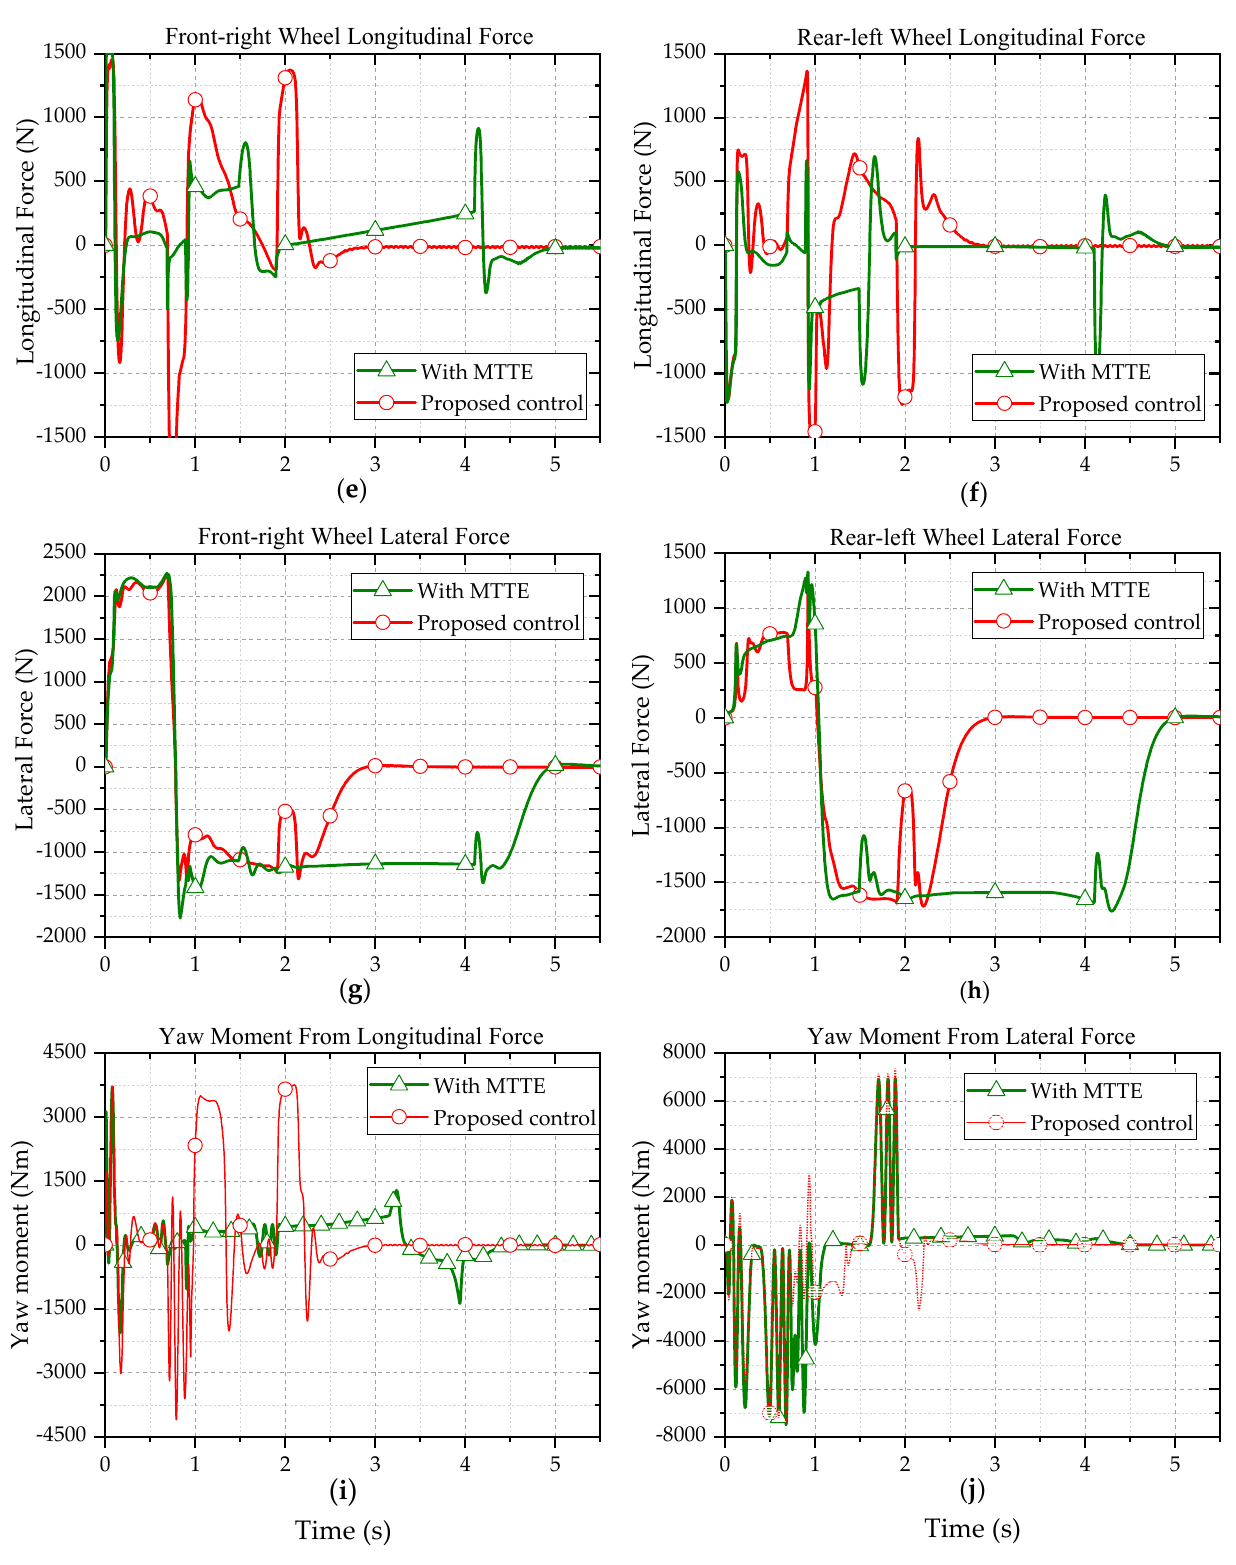
Figure 10. Comparison of intermediate results for sine with dwell: ( a ) front-right wheel speed and chassis speed; ( b ) rear-left wheel speed and chassis speed; ( c ) front-right wheel slip ratio; ( d ) rear- left wheel slip ratio; ( e ) front-right wheel longitudinal force; ( f ) rear-left wheel longitudinal force; ( g ) front-right wheel lateral force; ( h ) rear-left wheel lateral force; ( i ) yaw moment from longitudinal force; ( j ) yaw moment from lateral force.